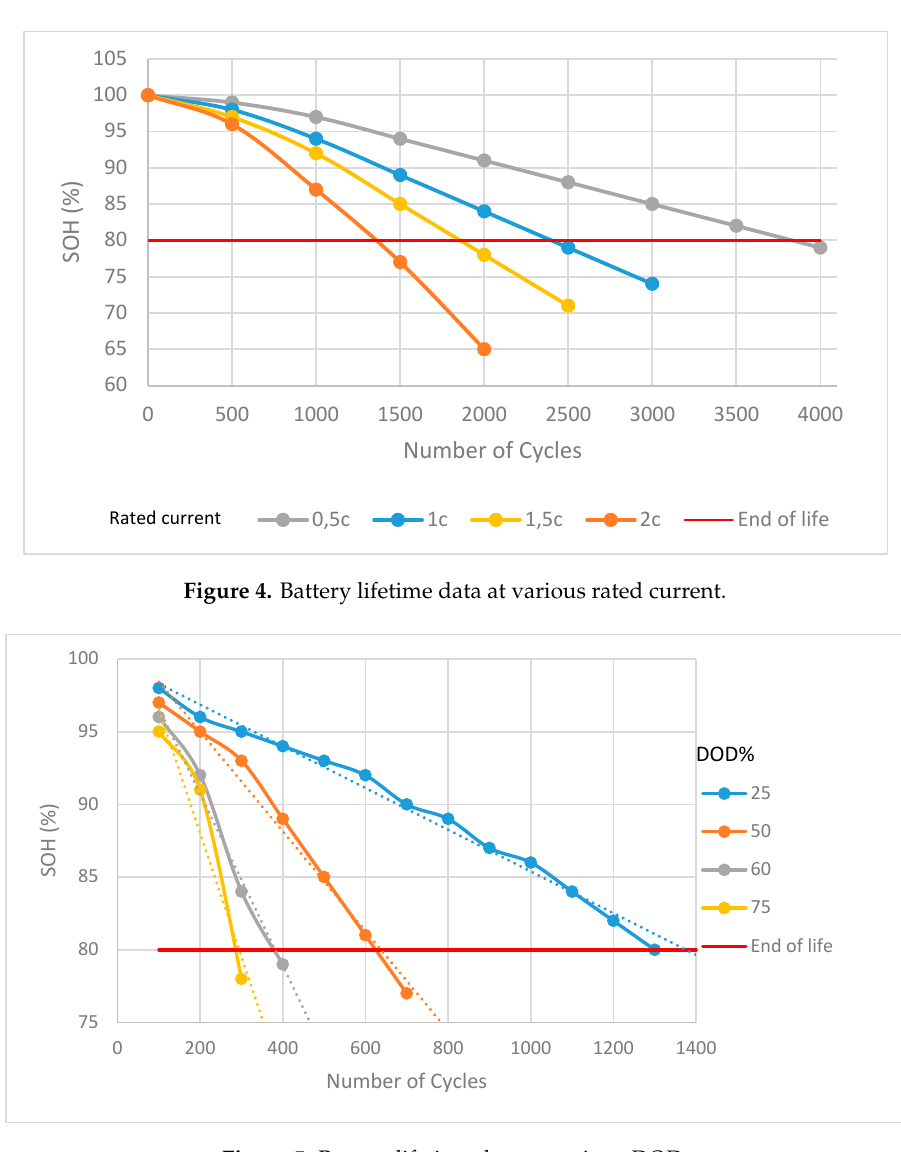
Figure 5. Battery lifetime data at various DOD.